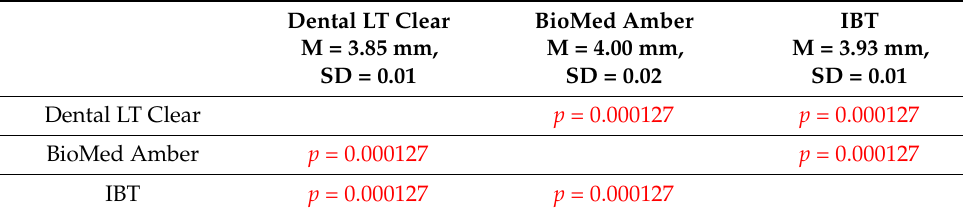
Table 6. Mean height differences in Tukey highly significant difference test between all materials (M—mean; SD—standard deviation; p — p -value; the statistical significance for p < 0.05 was presented in red).